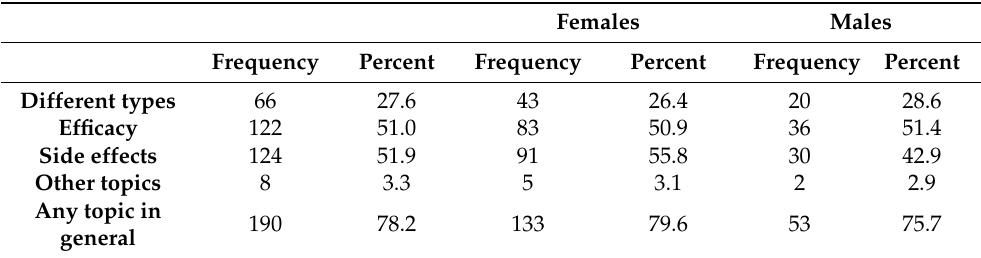
Table 3. Interest in further information on COVID-19